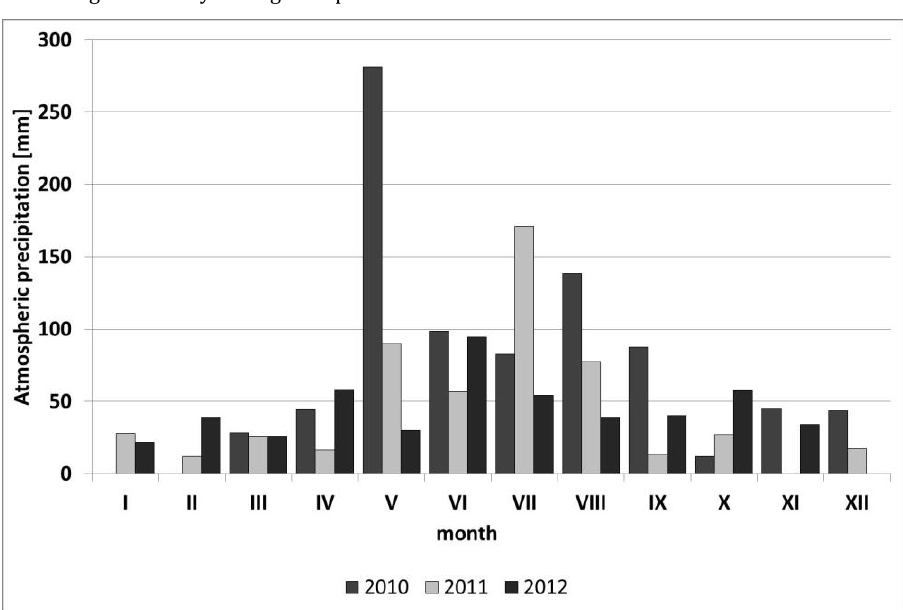
Fig. 4. Distribution of monthly precipitation totals in Goczałkowice between